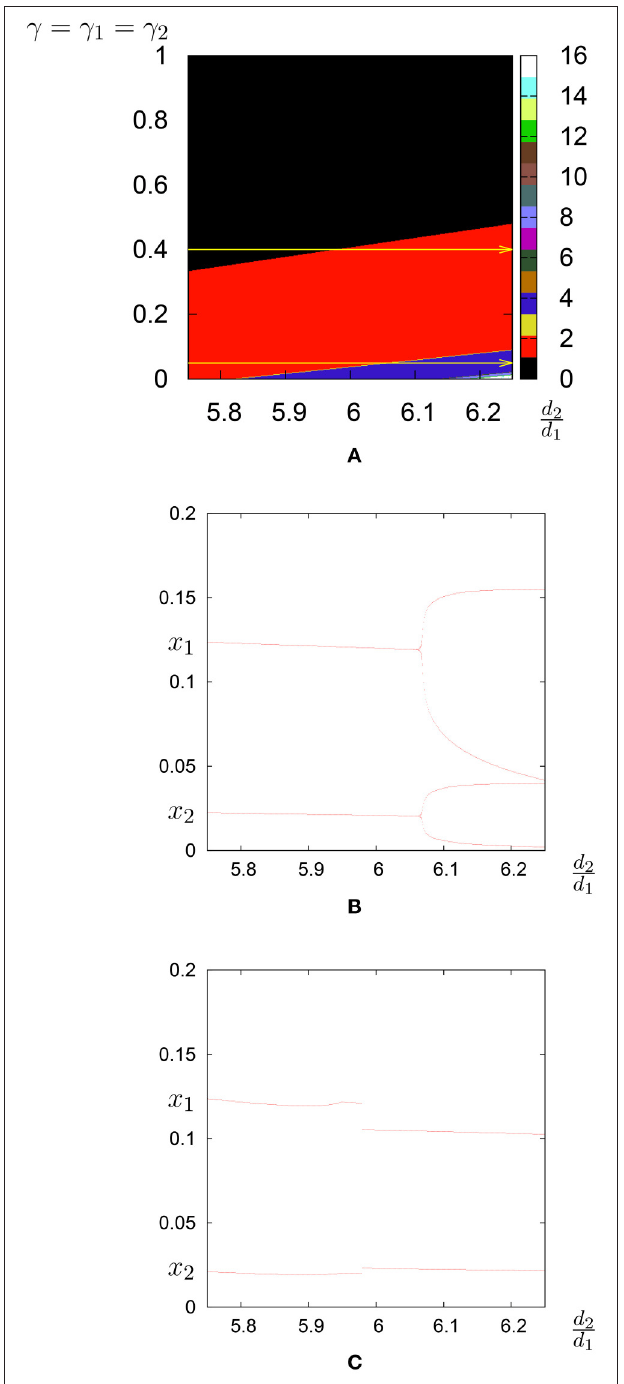
FIGURE 13 | Layoff cost. (A) Bifurcation diagram in the parameter plane d 2 / d 1 , δ δ 1 δ 2 ; the regions of different periodicity are represented by = = different colors. The horizontal yellow lines represent the line on which, in (B) , (cid:0) (cid:1) the bifurcation diagram is shown with δ bifurcation diagram is shown with δ